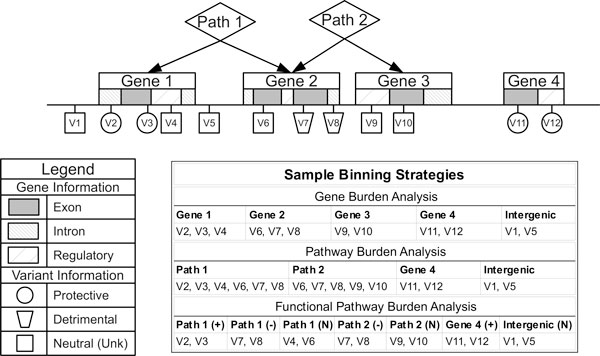
Example binning strategies. Binning example using four genes, two pathways, and functional prediction.